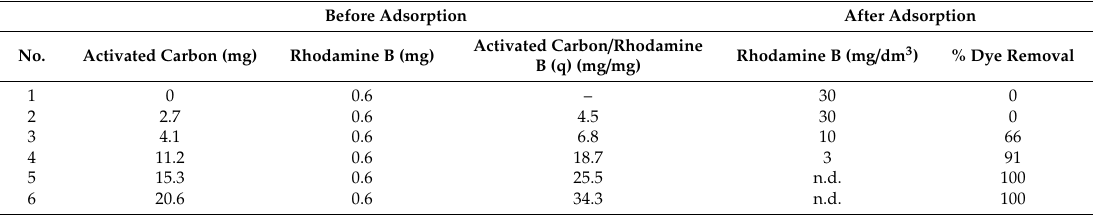
Table 3. The adsorption